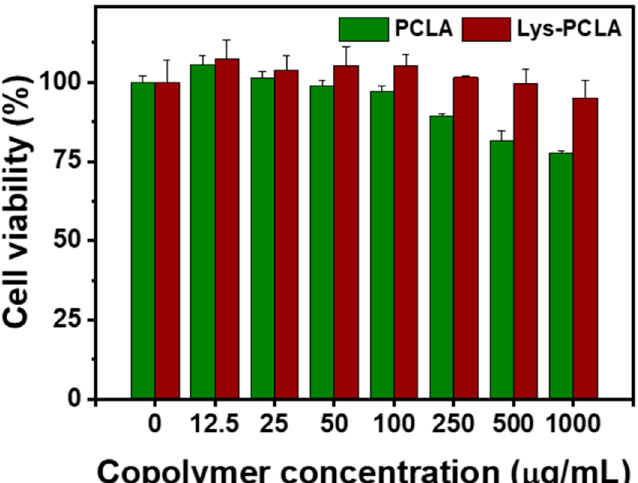
Figure 7. In vitro cell viability of RAW263.7 cells after incubation with different concentrations of PCLA copolymers and Lys-PCLA conjugates for 48 h. Data are presented as mean ± SD ( n = 4).